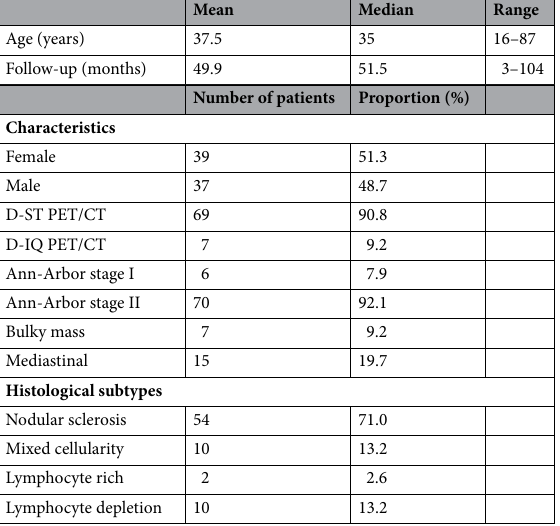
Table 1. Patients’